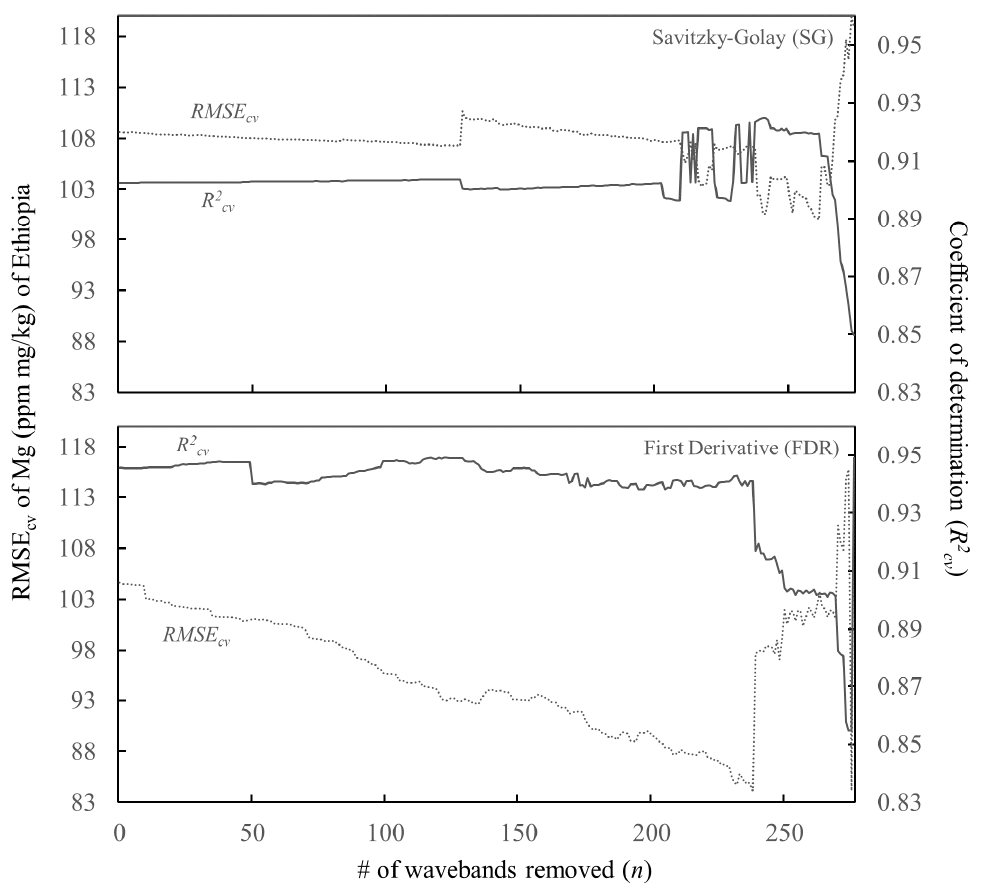
Figure 5. Representation of the iterative process to determine the number of wavebands via the waveband selection process. The number of wavebands is determined by the lowest RMSEcv value (dotted line), which in turn determines the coe ffi cient of determination (solid line) using the given number of wavebands in the partial least square regression (PLS). Top figure is for the Savitsky–Golay filtered data. The bottom figure is for the first derivative.